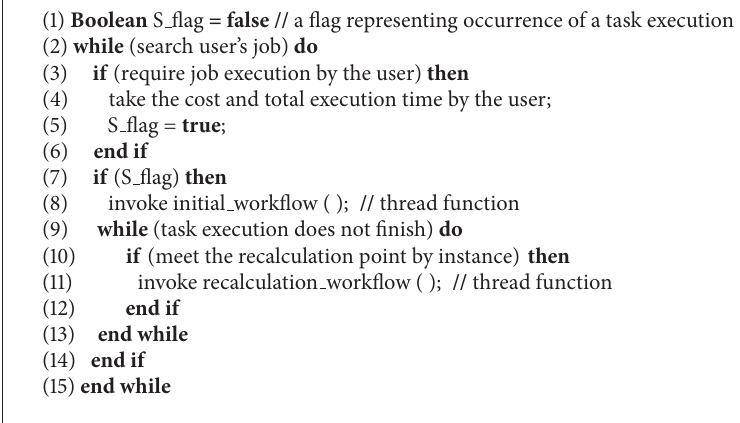
Algorithm 1: Workflow scheduling algorithm.